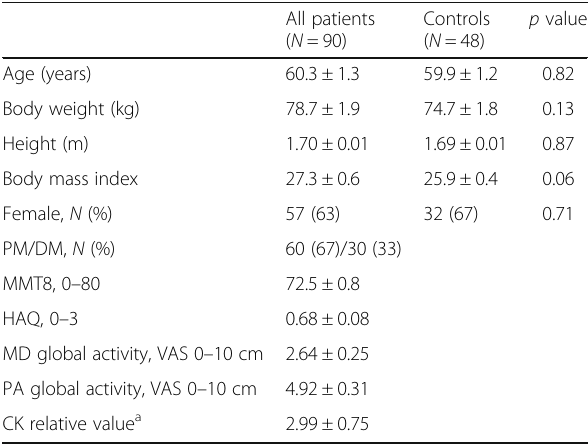
Table 1 Clinical characteristics of patients with polymyositis or dermatomyositis and control persons